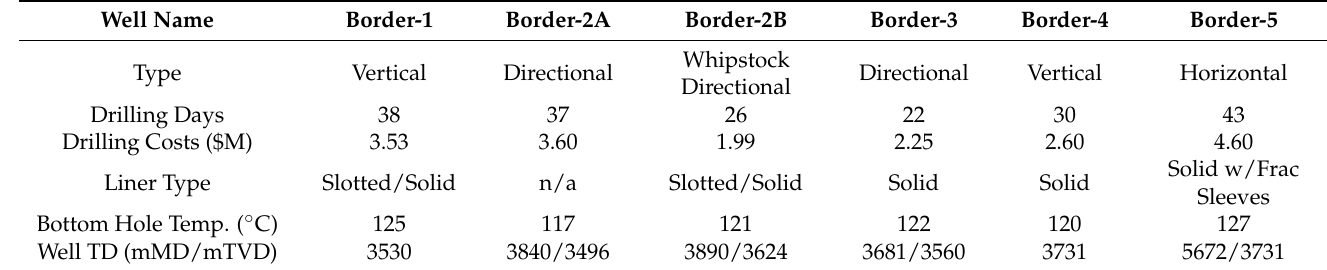
Table 1. Main characteristics of wells drilled to date at DEEP